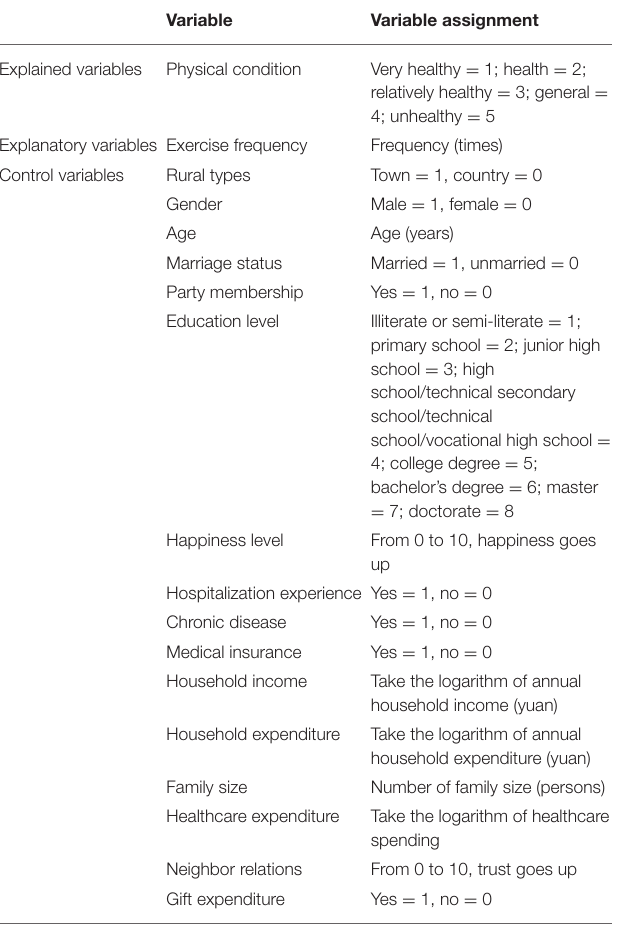
TABLE 1 | Variable definition and